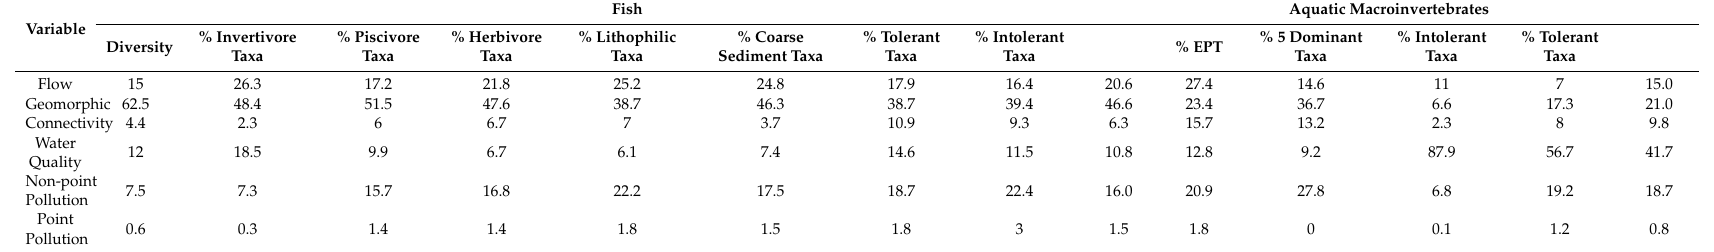
Table 5. Summary of the average relative influence for each theme on response variables modeled with the boosted regression trees for both fish and aquatic macroinvertebrates. The average thematic % relative influence is the percent relative contribution of each theme to the BRT model. Themes are comprised of flow condition (NID storage, dam density, altered streamflow, agricultural and industrial water withdrawals), geomorphic condition (erosive and resistive forces), connectivity (dam and road crossing density at the watershed and catchment levels), water quality (total nitrogen load, total phosphorous load, and dissolved organic carbon), non-point source pollution (% agricultural land cover, % impervious surface, and % natural land cover in the watershed, active river area, and catchment), and point source pollution (CERCLA site density, permit compliance system site density, toxic release site density, coal mine, wind turbine and natural gas well density, and mine